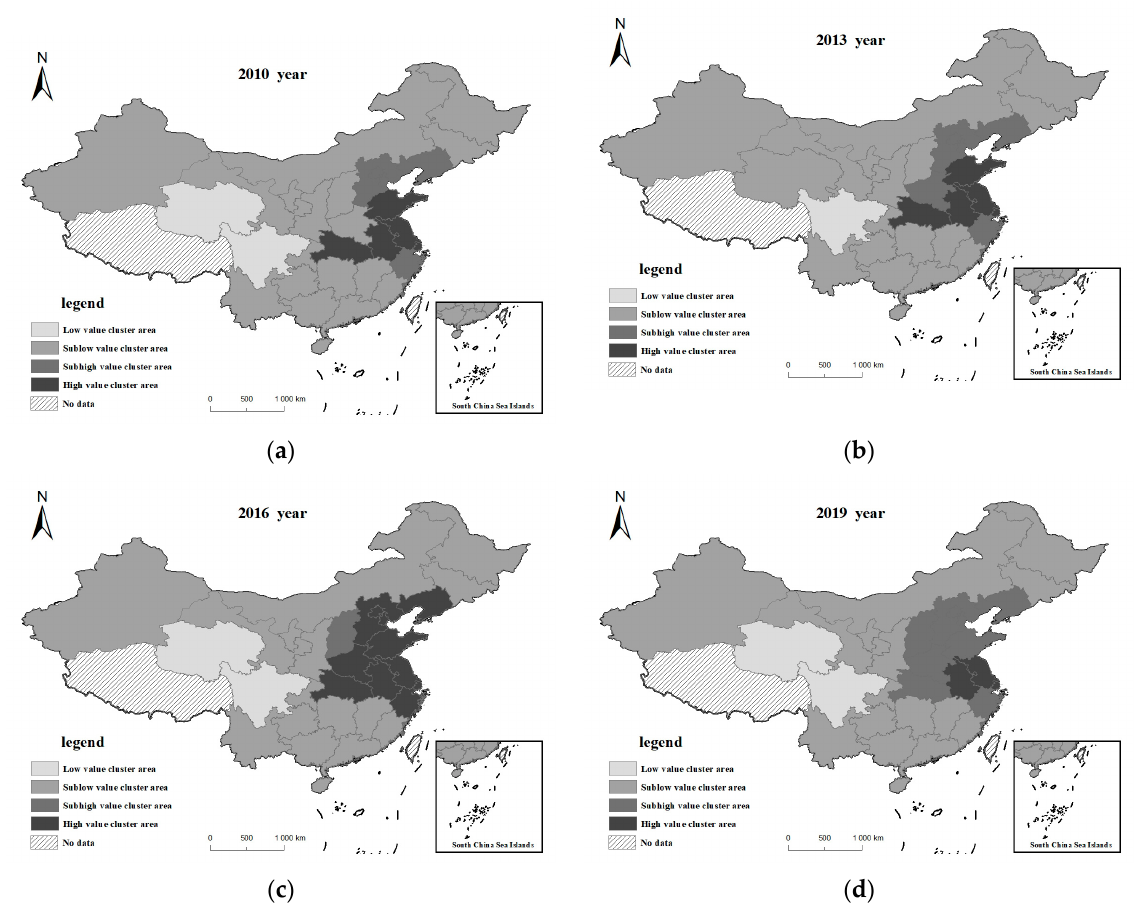
Figure 2. Spatial agglomeration pattern of public building carbon emissions in China from 2008 to 2019: ( a ) Spatial agglomeration pattern of public building carbon emissions in China in 2010; ( b ) Spatial agglomeration pattern of public building carbon emissions in China in 2013; ( c ) Spatial agglomeration pattern of public building carbon emissions in China in 2016; ( d ) Spatial agglomeration pattern of public building carbon emissions in China in 2019.